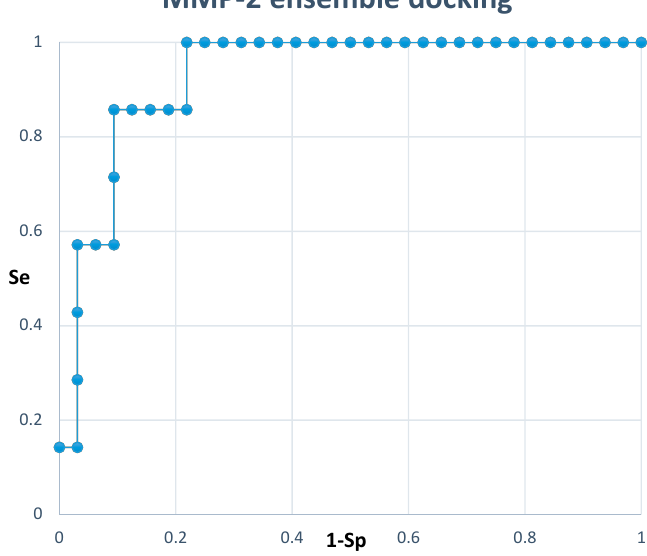
Figure 9. ROC plots obtained reporting the ranking of active compounds after ensemble docking.